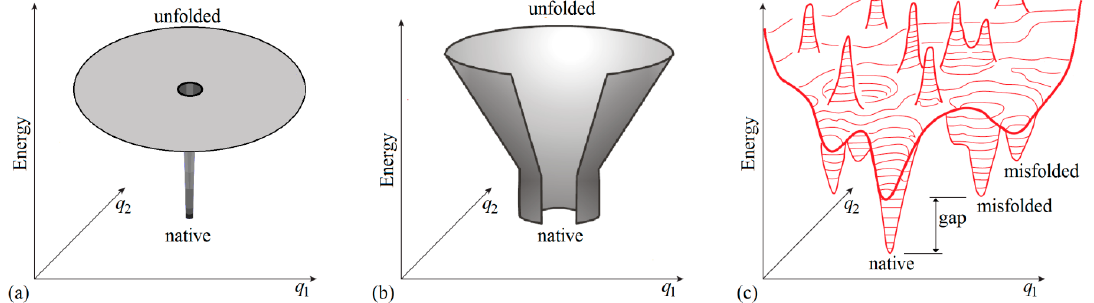
Figure 1. Illustrations of the protein energy landscape for di ff erent models. For illustrative purposes, the coordinates q 1 and q 2 schematically present the protein conformational space, which has, in reality, hundreds of dimensions. ( a ) The energy landscape for the “golf course” model. ( b ) A general “energy funnel” illustration. The funnel centers on the protein native structure having the lowest energy. (We should remind that the term "entropy" in the context of protein folding models conventionally refers only to the configurational entropy, while the term "energy" refers to the free energy of interactions, so that solvent-mediated forces (for example, hydrophobic and electrostatic ones), with all their solvent entropy [40] come within "energy"; therefore, we avoid applying the word “enthalpy” to protein folding models.) ( c ) A more detailed general energy landscape. The term “gap” denotes an energy gap between the global and other energy minima, necessary to provide the “all-or-none” transition between native and other structures of the chain. The gap must be large enough, of many k B T melt , where T melt is protein melting temperature (thus, usually, k B T melt ≈ 0.7 kcal / mol). Adapted from [46] with some modifications.